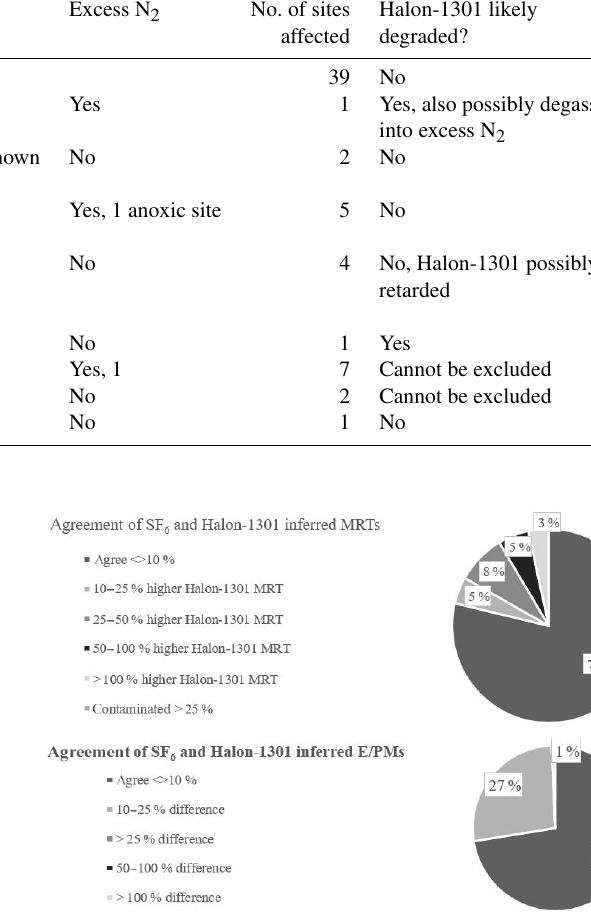
Figure 10. Summary of the performance of Halon-1301 as an age tracer compared to SF6 in predicting the MRT (a) and the mix- ing parameter E / PM (b) . Overall, at 79% of the sites MRTs agree within ±